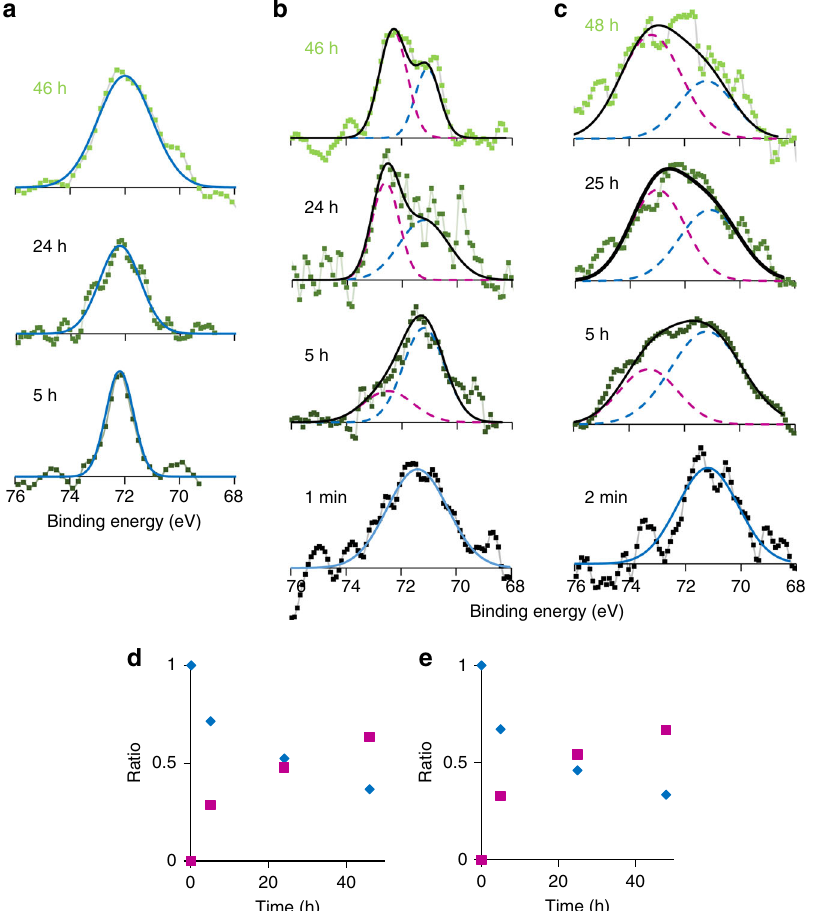
Fig. 3 Change in the XPS Al 2 p peaks upon air exposure. The graphs show the spectral change for the Al n clusters. a n = 13, b n = 12, and c n = 14. The exposure times were 1 – 2 min, 5 h, 24 – 25 h, and 46 – 48 h. The vertical axes are normalized intensity. The spectra for Al 12 and Al 14 samples could be fi tted by two peaks derived from the initial reduction peak (blue dashed line) and oxidation peak (red dashed line). Ratio of the oxidized (red squares) to the as-